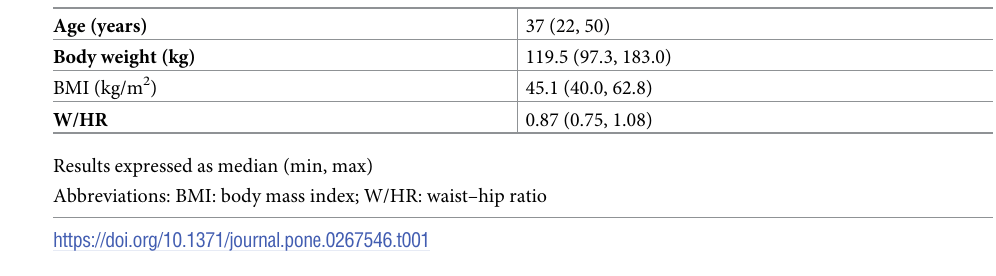
Table 1. Anthropometric and demographic data of the participants.